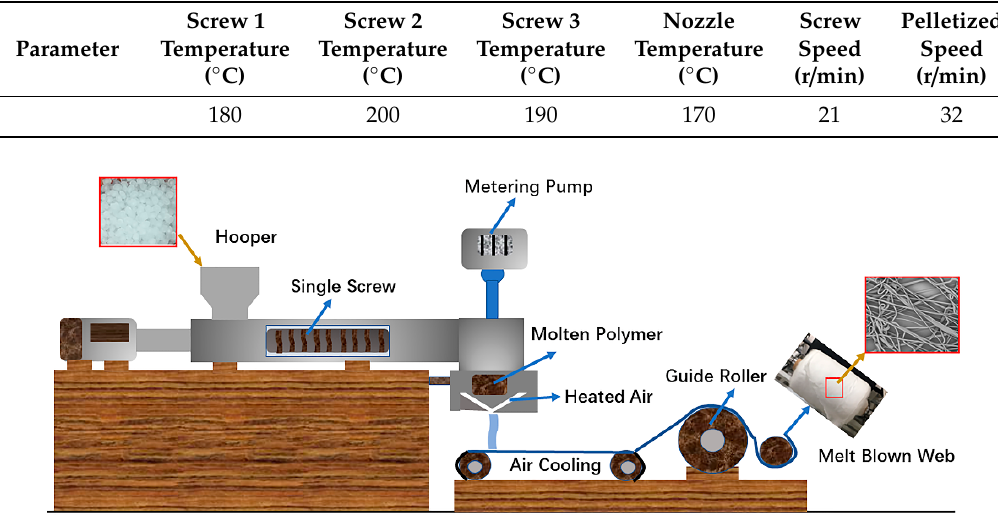
Figure 1. The melt-blowing process of polypropylene/titanium dioxide (PP/TiO 2 ) melt-blown